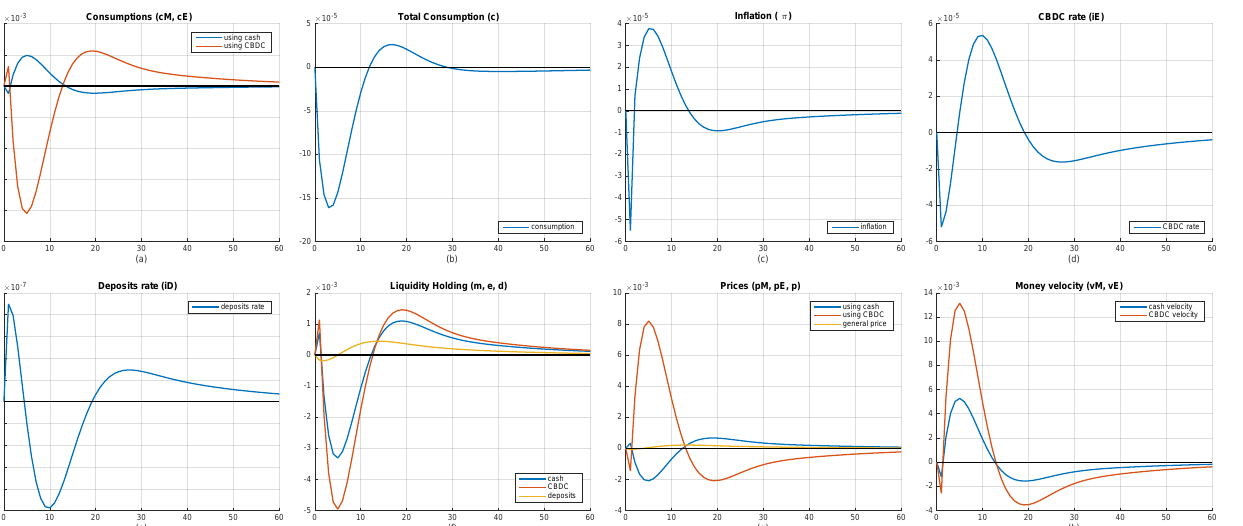
, ( e ) deposits rate i D , t t − m t and = c M t t